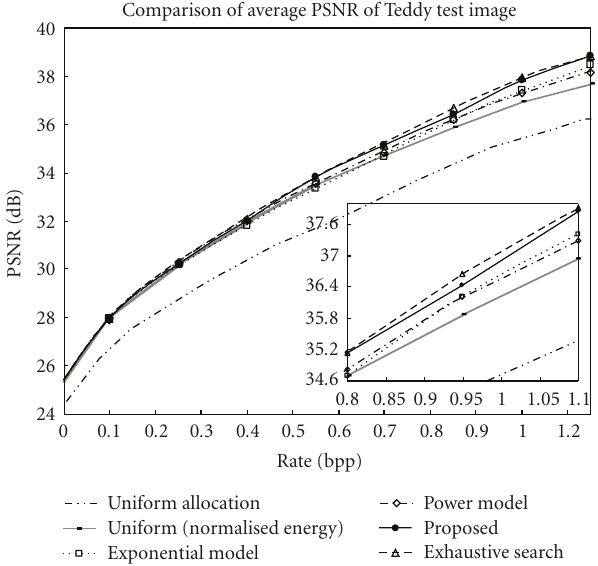
Figure 10: PSNR comparison of Teddy test image as in Figure 8 using method in